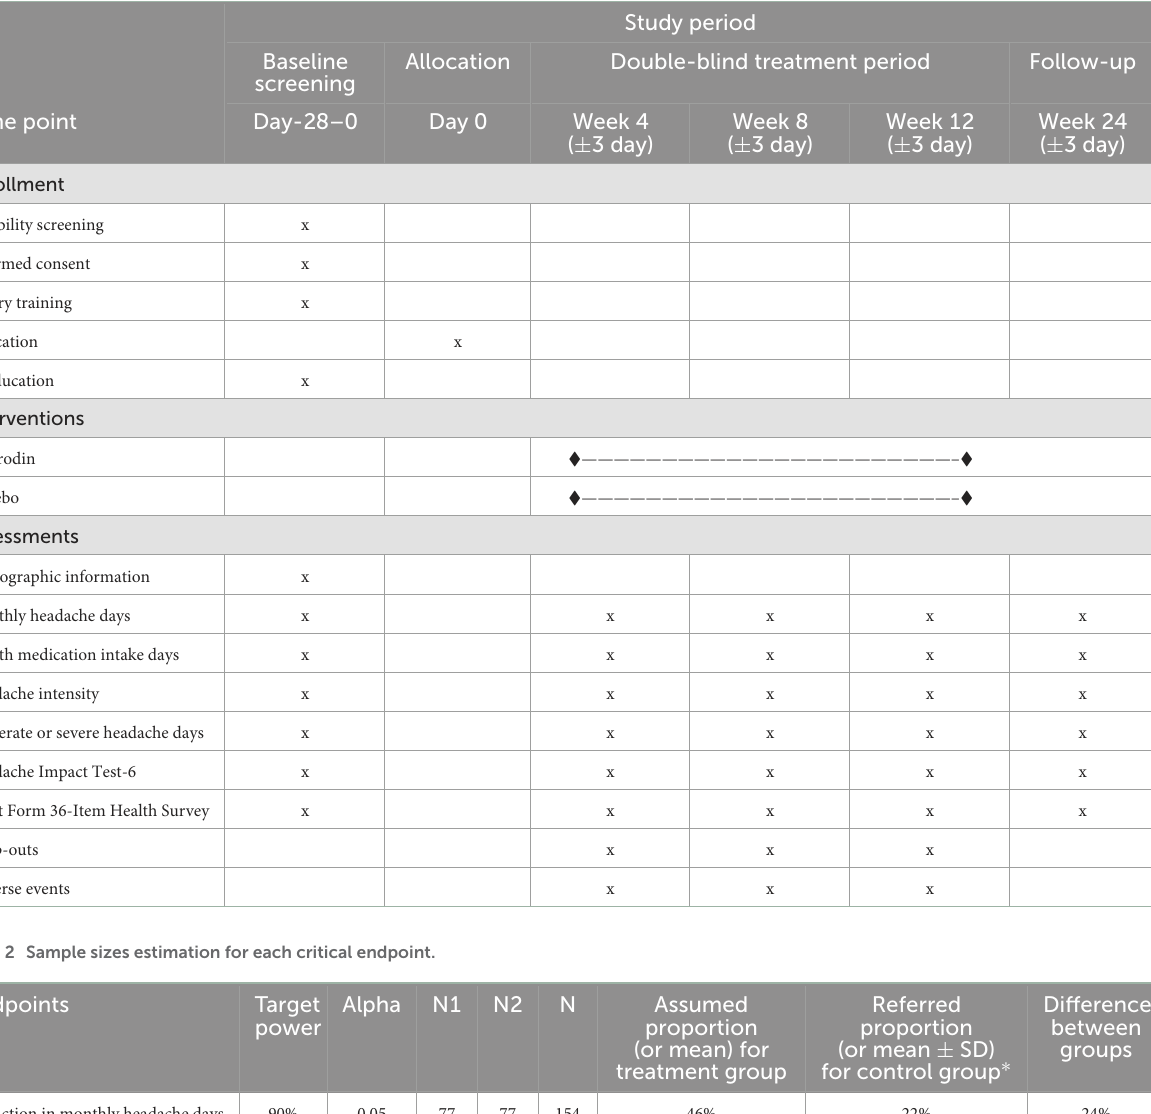
TABLE 1 SPIRIT flow diagram of enrollment, interventions, and assessments.